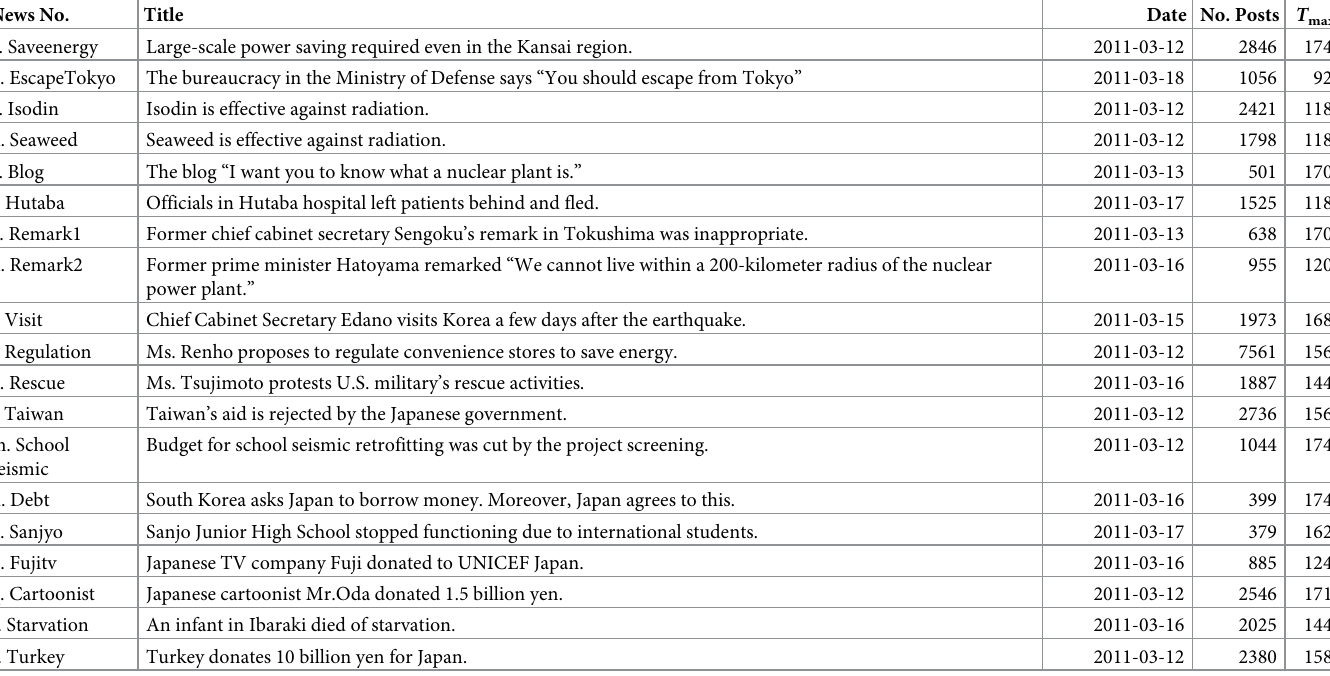
must be longer than 36 hours (as indicated by the experiments conducted on synthetic data, Fig 2). A summary of the collected fake news stories is presented in Table 1. Fake news on the 2011 Tohoku earthquake and tsunami (Tohoku) Numerous fake news stories emerged after the 2011 earthquake off the Pacific coast of Tohoku [3, 4]. We collected tweets posted in Japanese from March 12 to March 24, 2011, by using sam- ple streams from the Twitter API. There were a total of 17,079,963 tweets. We first identified 80 fake news items based on a fake news verification article [43] and obtained the keywords and related URLs of the news items. Then, we extracted the tweets highly relevant to the fake news. Finally, we selected 19 fake news stories using the same conditions as in the RFN dataset. A summary of the collected fake news items is presented in Table 2. Table 2. 2011 Tohoku earthquake and tsunami (Tohoku): Details of 19 Japanese fake news items. News